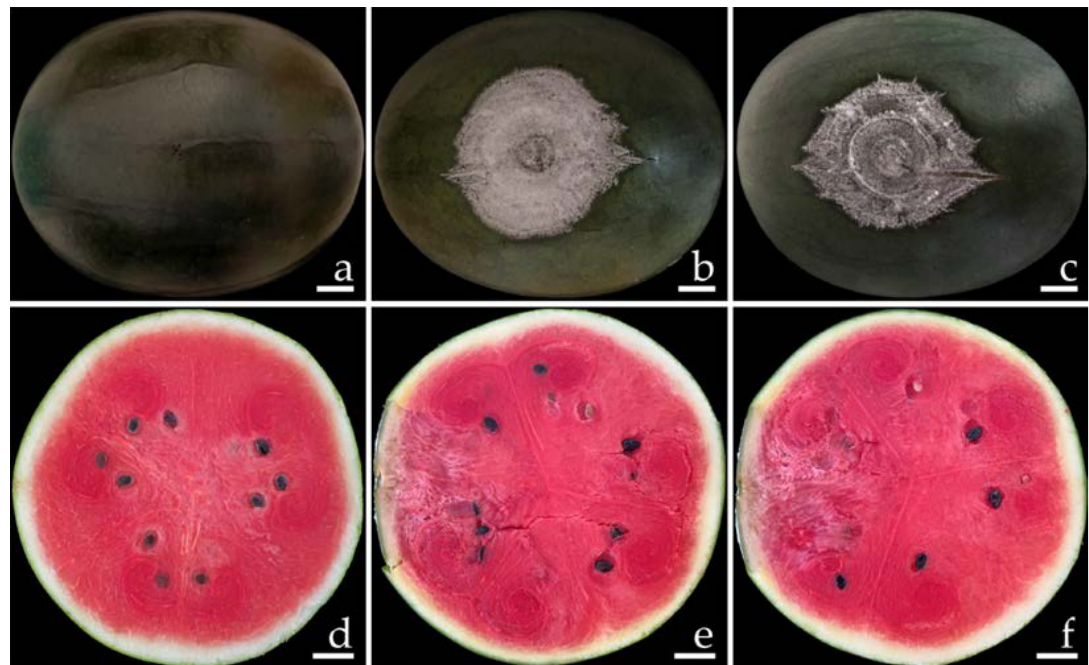
Figure 7. Pathogenicity test with F. paranaense SDBR-CMU463 and SDBR-CMU464 on watermelon fruits after seven days of inoculation. Control fruit inoculated with sterile water ( a , d ); and disease symptoms after inoculation with isolate SDBR-CMU463 ( b , e ) and isolate SDBR-CMU464 ( c , f ). Scale bars = 20 mm.